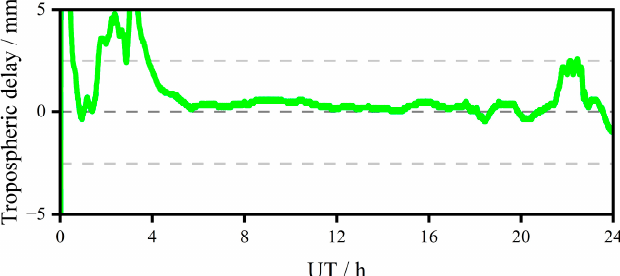
Figure 15. Differences of tropospheric delay of UC123-0 model at AREG.